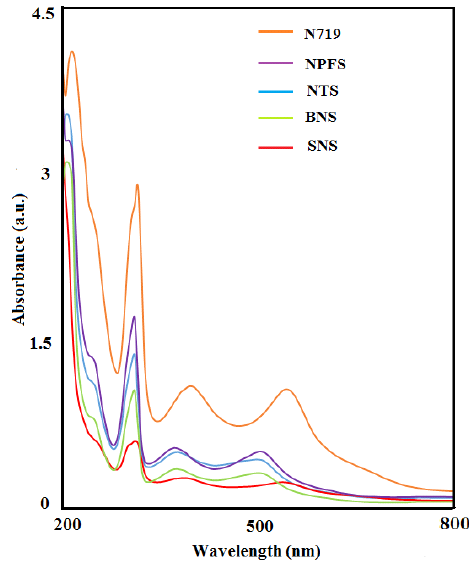
Fig. 4. UV-Vis absorption spectra of the absorbed dye molecules (N719 dye) on different photoelectrodes of TiO